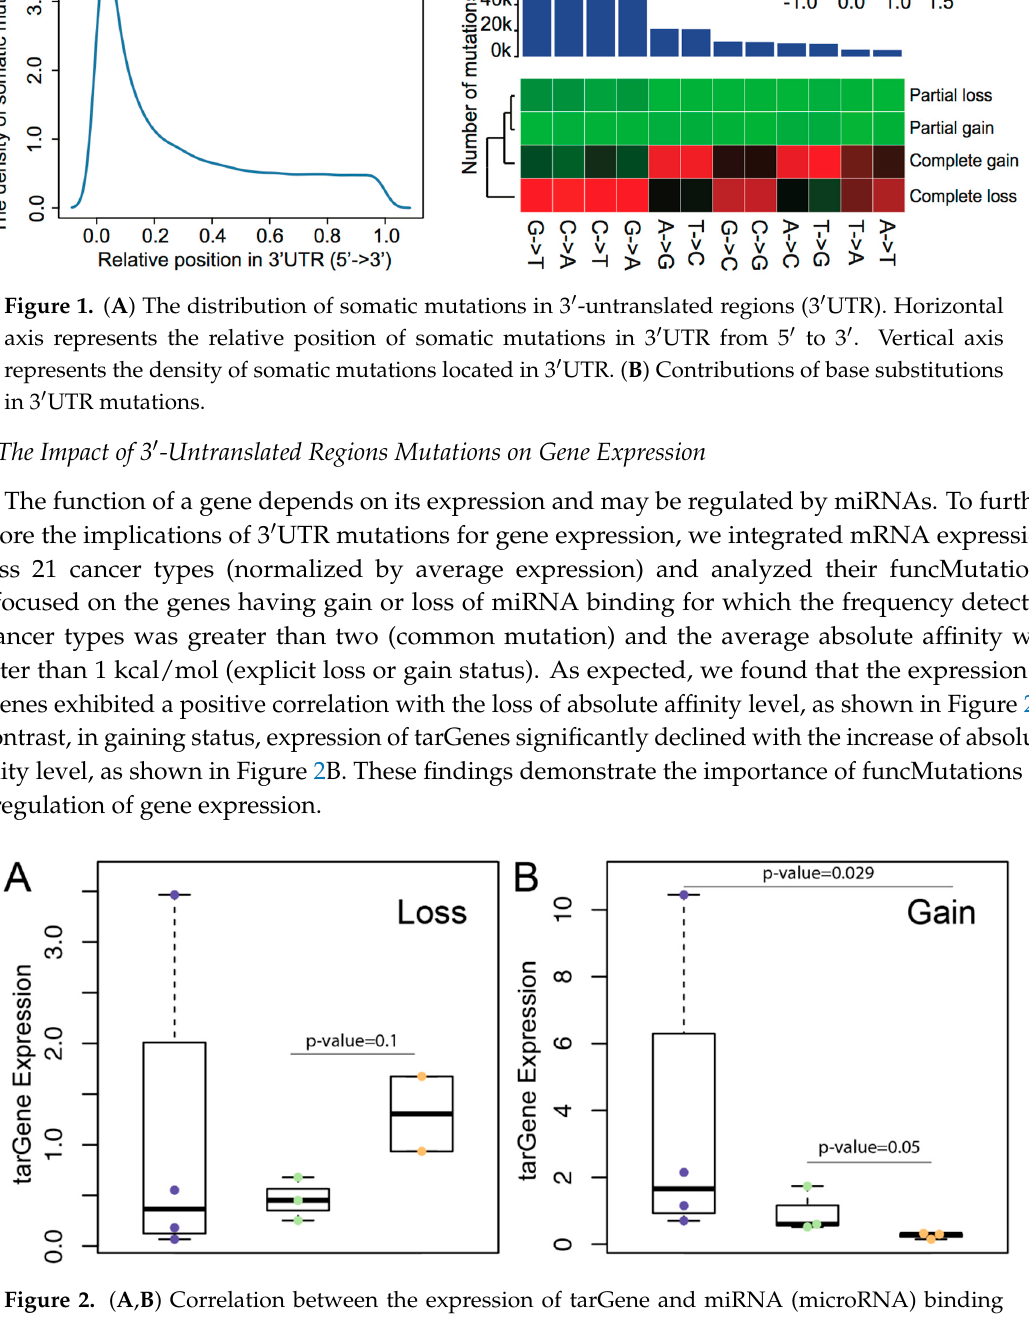
Figure 2. ( A , B ) Correlation between the expression of tarGene and miRNA (microRNA) binding absolute affinity ( A : loss status, B : gain status). Vertical coordinate represents the ratio of the gene expression in mutated sample to the mean of gene expression level in all samples. Three colors represent different degrees of the absolute affinity level. Statistical testing was performed using the Wilcoxon rank-sum test.